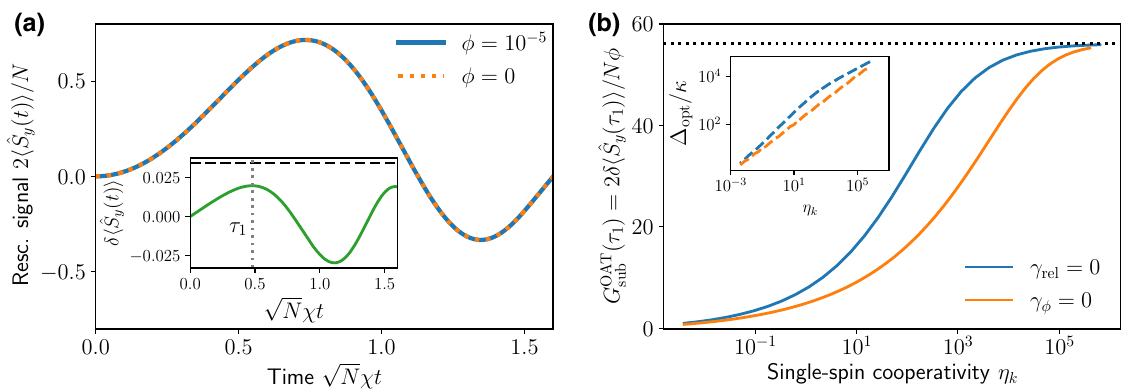
FIG. 10. Analysis of the OAT spin-amplification protocol proposed in Ref. [26] for an ensemble of N standard two-level systems (cid:5)ˆ coupled to a detuned bosonic mode via a Tavis-Cummings coupling. The initial signal is encoded in S z (cid:6) , the value of which is then (cid:5)ˆ (cid:5)ˆ transduced to S y (cid:6) with gain [see Eq. (37)]. (a) The time evolution of S y (cid:6) , both with (solid blue curve) and without (dashed orange curve) an initial small signal φ [obtained by numerically exact solution of the master equation (39) for N = 500, (cid:5) coll /χ = 0.02, and γ /χ = γ /χ = 0]. Collective decay leads to a large average value of (cid:5)ˆ S (cid:6) even without any initial signal φ . The inset shows the φ rel y ˆ ˆ ˆ tiny signal obtained after subtraction of this background, δ (cid:5) S y ( t , φ) (cid:6) − (cid:5) S y ( t , 0 ) (cid:6) . The black dashed line is the optimal gain S y ( t ) (cid:6) = (cid:5) (τ ) , in that one could reach in the absence of collective dissipation. (b) The scaling of the gain after background subtraction, G OAT 1 sub the presence of collective decay and either single-spin dephasing (blue curve) or single-spin relaxation (orange curve) as a function of the respective single-spin cooperativity η k = 4 g 2 /κγ k with k ∈ { φ , rel } . We evaluate the gain at its first peak at time t = τ 1 [indicated in the inset of (a) by the gray dotted vertical line], which is the time of maximum gain if local dissipation is taken into account. (τ ) is strongly reduced compared to its ideal value in the absence of dissipation (dotted black line; note that MFT The gain G OAT √ 1 sub predicts this quantity to be slightly smaller than master-equation simulations), unless the single-spin cooperativity satisfies η φ (cid:7) N or η rel (cid:7) N 0.9 (see the Supplemental Material [53]). The simulations are done using MFT for N = 10 4 spins. For each η k , the detuning (cid:17) is optimized using the optimized values shown in the inset. Resc.,